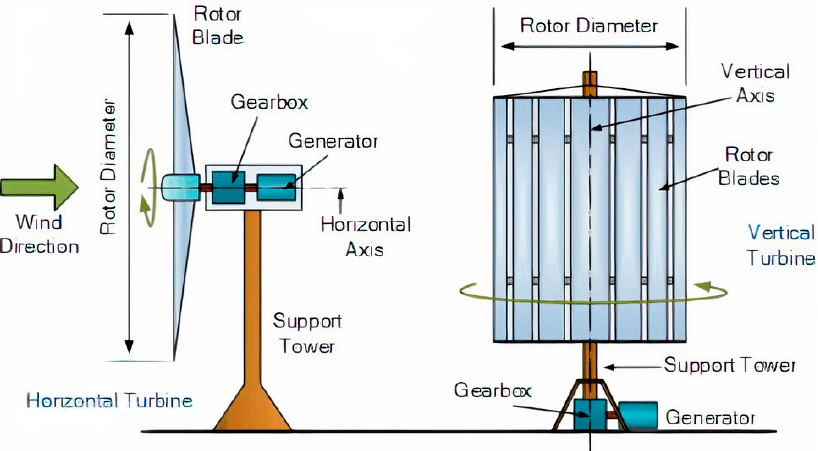
Figure 3. Wind turbine types: VAWT and HAWT [66]. (Open Access).